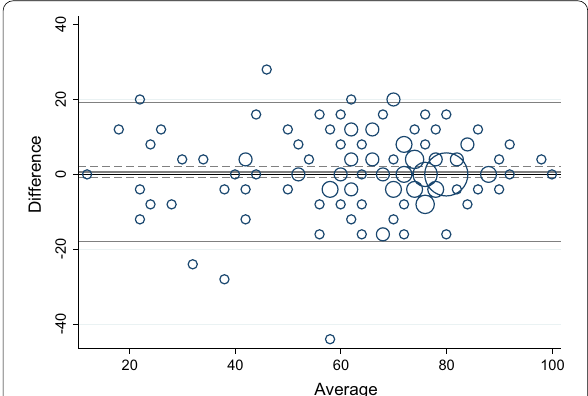
Fig. 1 Differences in the WHO-Five Well-being Index scale between first and second questionnaire responses (Test 1 and Test 2) plotted against the mean, N 145 =